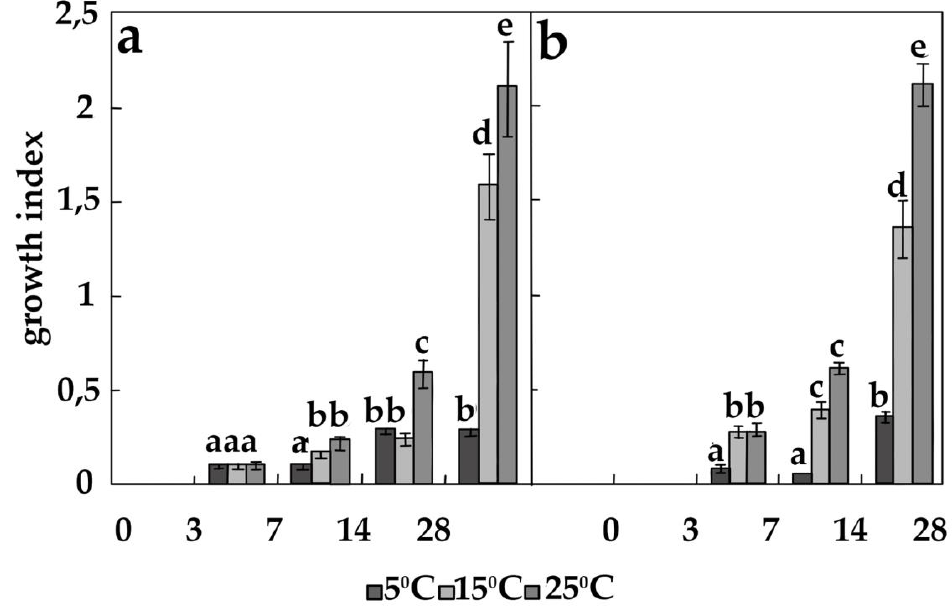
Figure 2. ( a ) Growth index of calli, ( b ) growth index of hairy roots of Rhodiola quadrifida . For the first week, the temperature had no effect on root growth. Differences ap- peared in the second week: in the roots grown at 15 and 25°C, the growth was 3 times higher compared to the roots grown at 5°C. The greatest increase in root mass was noted in all variants in the period of 14 – 28 days (Figure 2b). 3.2. The Content of the Main Phenolic Compounds in Calli and Hairy Roots The absence of tyrosol and rosarin was shown in the study of the content of the main phenolic compounds of Rhodiola quadrifida in all samples of the studied cultures, and the absence of rosinin the root culture. The total content of the main substances studied was low and amounted to a maximum of 0.051 mg/g for calli and 0.00274 mg/g for roots. The content of salidroside in calli of all the variants was similar during the first three days of cultivation (Figure 3). Then, at 15 and 25°C, the content of salidroside gradually decreased by the end of the cultivation cycle and was 23% less compared to 5°C. Although the content of salidroside in calli at 5°C changed slightly during the entire cultivation cycle, on the 14th day it increased by 25% and was the highest in the whole experiment. The content of salidroside in the roots was an order of magnitude lower than in the calli, and when cultivated at different temperatures it did not change reliably for 28 days.